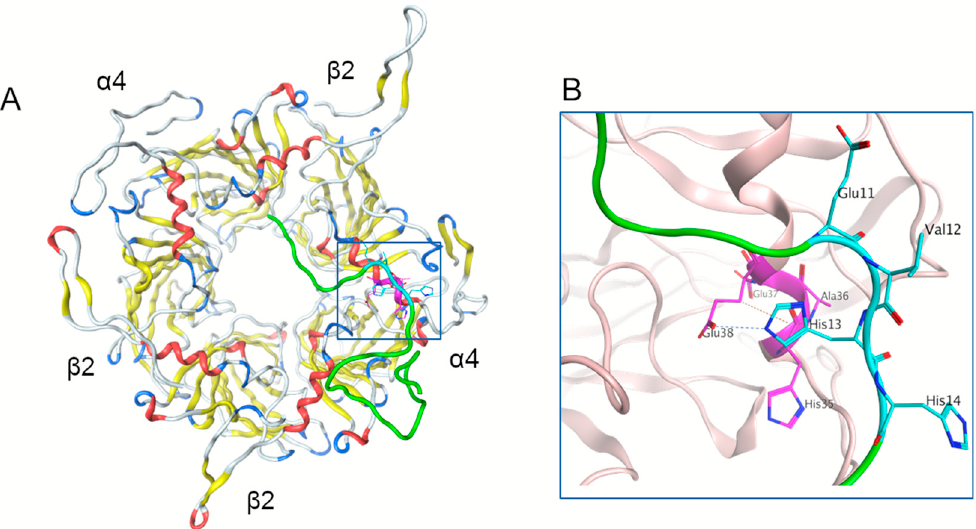
Figure 1. Model of the interaction of the α 4 β 2 nAChR site 35 HAEE 38 with A β 42 after 100 ns of molecular dynamics structure equilibration. ( A ) Model of the α 4 β 2 structure with bound A β 42 peptide, viewed from the extracellular side. ( B ) Detailed view of the interaction interface. The A β 42 peptide is colored green with the 11 EVHH 14 site shown in cyan. The 35 HAEE 38 site is colored magenta. The N-terminal α -helix of both α 4 and β 2 subunits is colored red.